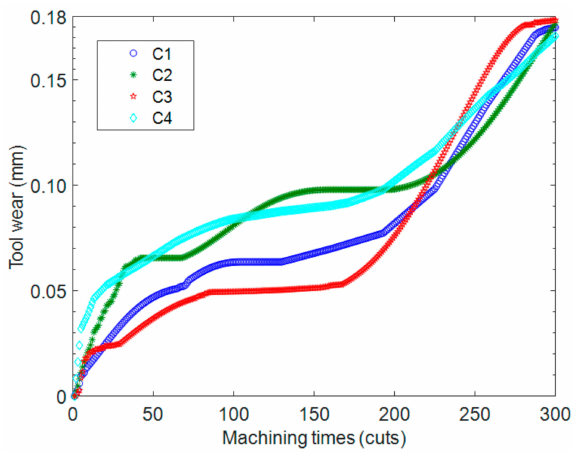
Figure 14. The relationship of tool wear and machining